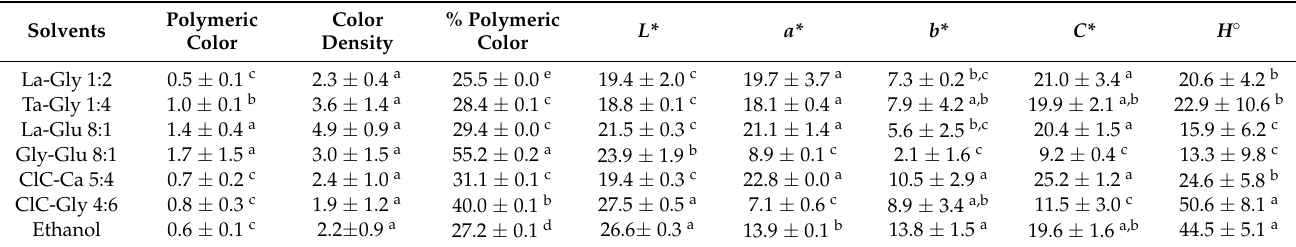
Table 2. Extracts with higher anthocyanin content (polymeric, density, and CIELAB parameters of color).